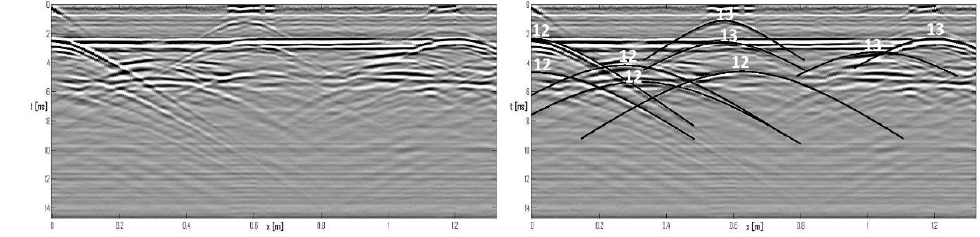
Figure 4. Pre-migrated data. The Bscan is the same on the left-hand and on the right-hand panel. On the right-hand side, model diffraction hyperbolas are superposed on the data to match them. The procedure is manual. The numbers on the hyperbolas indicate the trial propagation velocity in cm / ns.